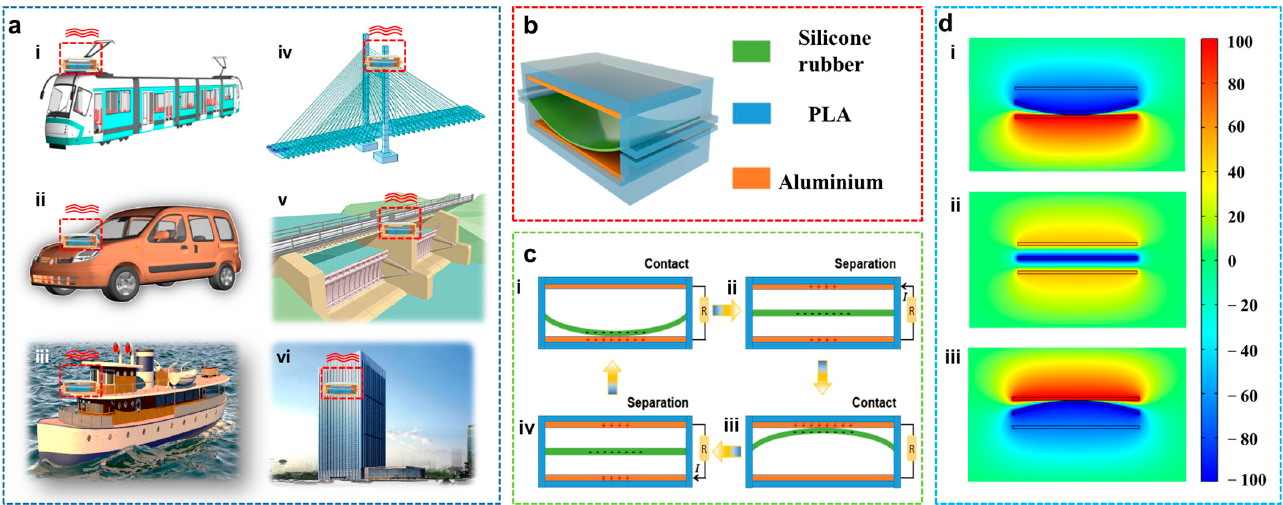
Figure 1. Application scenario, structure and working principle of SRS-TENG. ( a ) SRS-TENG ap- plication in various scenarios, such as ( i ) metro, ( ii ) vehicle, ( iii ) ship, ( iv ) bridge, ( v ) hydroelectric power plant, and ( vi ) building. ( b ) The structure and ( c ) ( i – iv ) working mechanism of the SRS-TENG; ( d ) ( i – iii ) the potential distribution of two parallel electrodes at different states calculated by COMSOL Multiphysics (COMSOL Inc., Stockholm, Sweden).